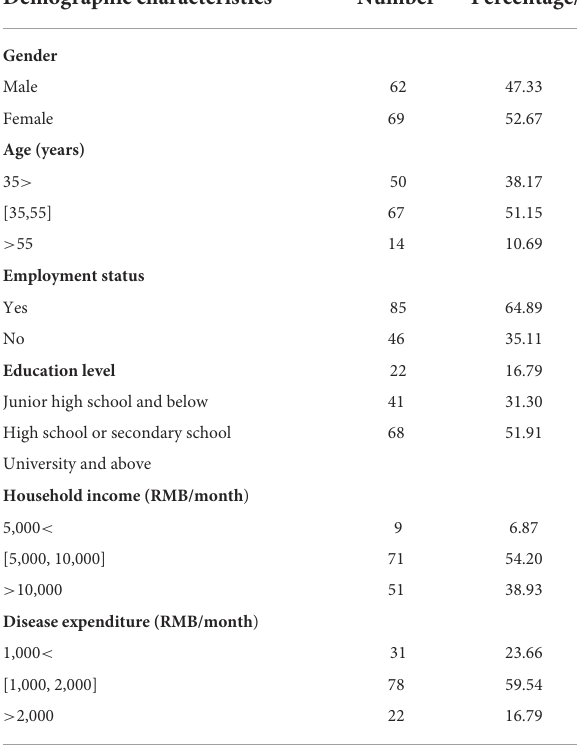
TABLE 2 Demographic information of CKD patients ( n =